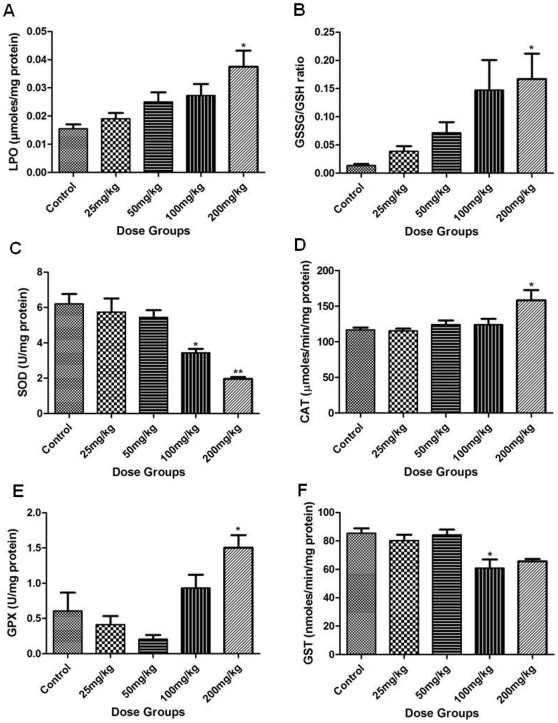
Level of oxidative stress parameters.(A) Lipid peroxidation level, (B) Ratio of GSSG/GSH, (C) activity of SOD, (D) activity of CAT, (E) activity of GPx, and (F) activity of GST were estimated in liver following the administration of Apigenin at different doses (Control, 25, 50, 100 and 200 mg/kg). The asterisks indicate significance of differences (*-p<0.05; **-p<0.01; ***- p<0.001) in comparison to control.